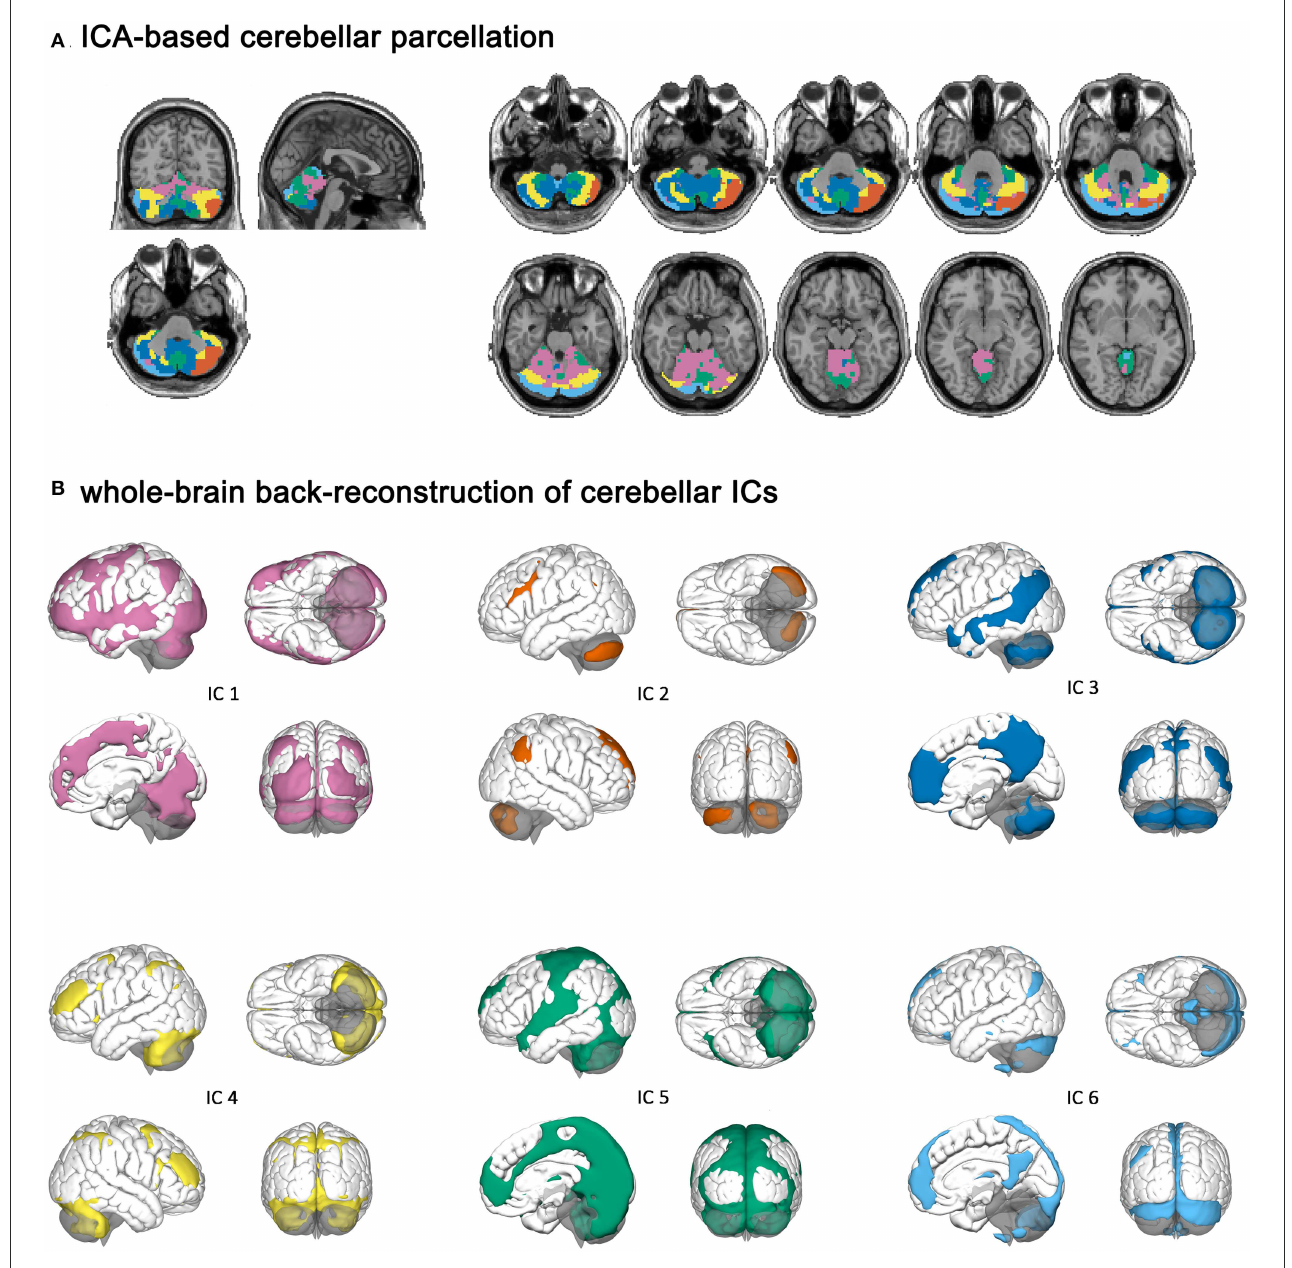
FIGURE1 Cerebellar independent components and their cerebral parcellations. (A) ICA-based cerebellar parcellation. (B) Whole-brain back-reconstruction of cerebellar ICs.